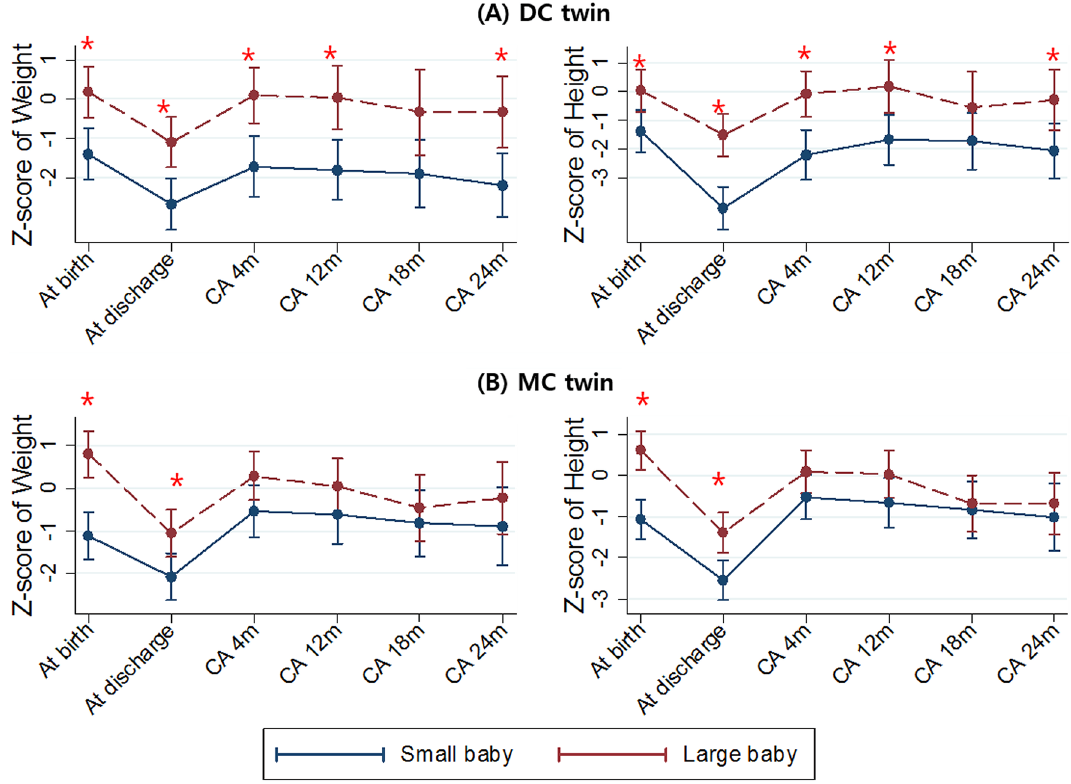
Figure 2. Growth of small and large infants of discordant dichorionic twin ( A ) and discordant monochorionic twin ( B ).CA, corrected